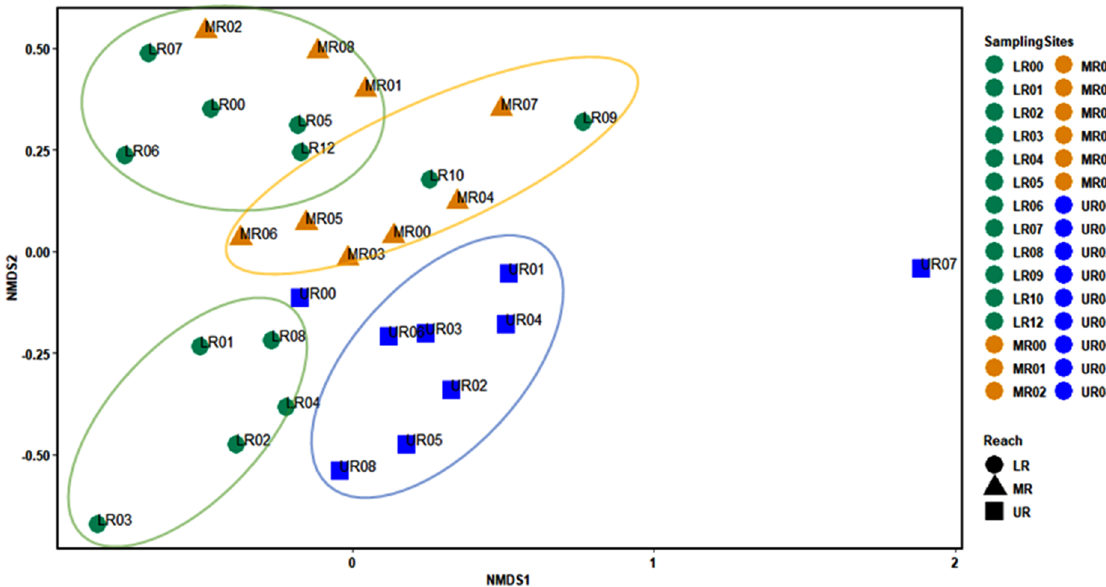
Figure 8. Macroinvertebrate abundance across reaches and flow extent in March 2020.